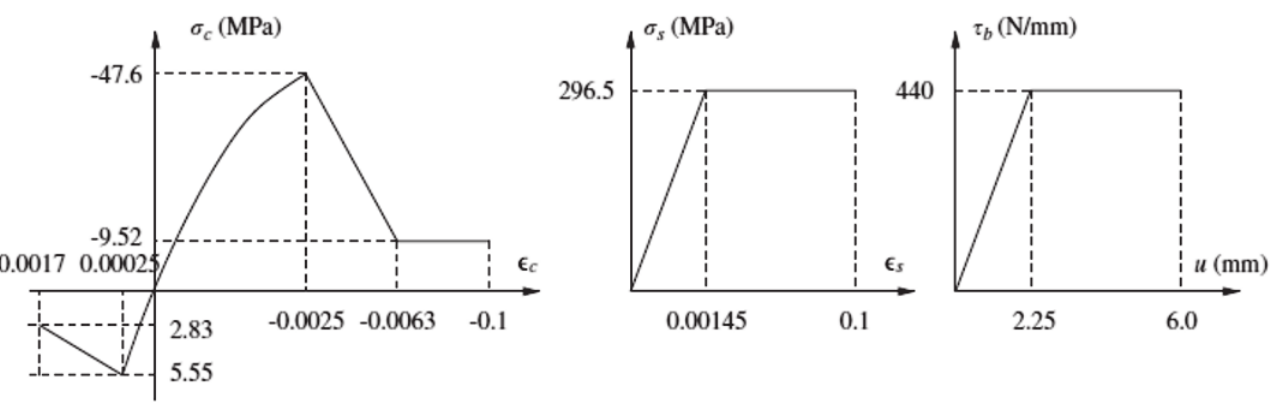
Figure 4 Constitutive laws used by Salari and Spacone [25], respectively: concrete, steel (profile and reinforcement) and interface